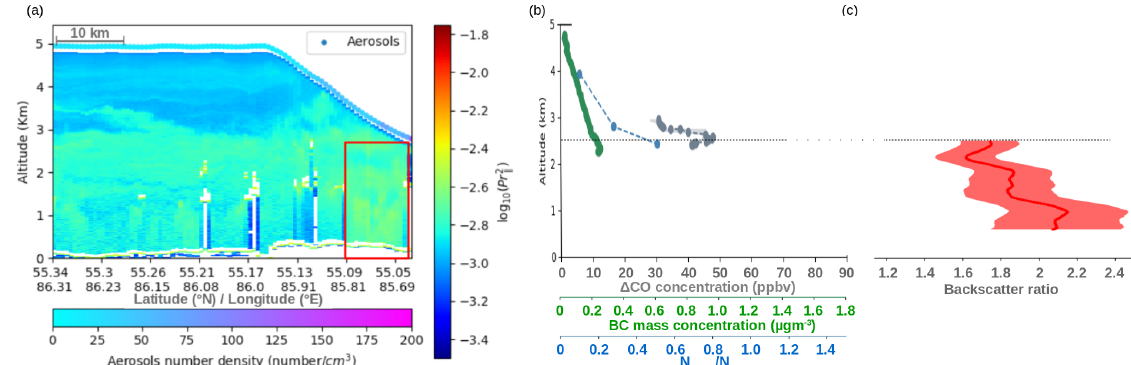
( PR 2 ) on 20 July 2013, 06 UT. Calibration constant is 136,203 ± 5%. Figure 18. ( a ) Vertical cross-section of aircraft log 10 Grimm aerosol concentrations in particle.cm − 3 are shown at the aircraft altitude. ( b ) Vertical profiles of ∆ CO in ppbv (grey), BC in µ g.m − 3 (green) and ratio of N 80 − 200 /N A (blue dashed line) for the descent from 5 km to 2 km at 86 ◦ E. ( c ) Backscatter ratio vertical profile for the lidar data in the red box. The horizontal dotted line is the top of the aerosol layer according to the lidar data.